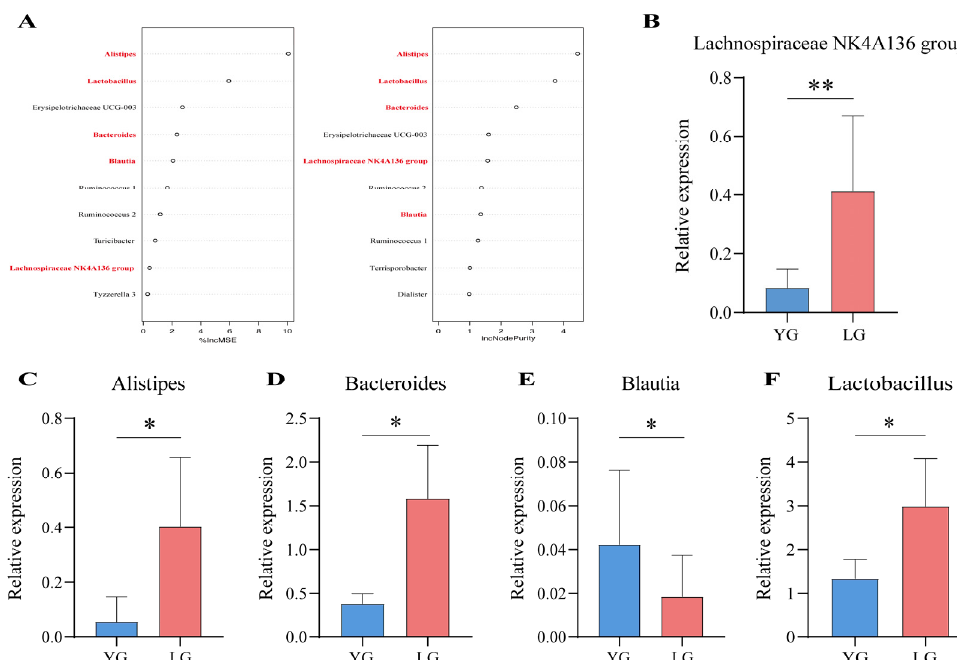
Figure 4. Random forests and differential gene expression identify key genera in the longevity core module. ( A ) Random forest prediction of iconic longevity taxa within the module and ranking of top 10 importance based on longevity phenomena, with taxa in bold indicating that they are also present in the top 10 results for network-centric colonies in the core module. On the left-hand side of the figure, the increase in mean-squared-error (IncMSE) ranking is indicated, and on the right-hand side the increase in node purity (IncNodePurity) is indicated, with higher values of %IncMSE as well as IncNodePurity indicating higher importance of the variable. ( B – F ) Results of qPCR relative expression tests for key gut microbiota, with both YG and LG groups using non-longevity area seniors as controls. ( B ) indicates Lachnospiraceae NK4A136 group , ( C ) indicates Alistipes , ( D ) indicates Bacteroides , ( E ) indicates Blautia , and ( F ) indicates Lactobacillus . * indicates p < 0.05 and ** indicates p < 0.01.